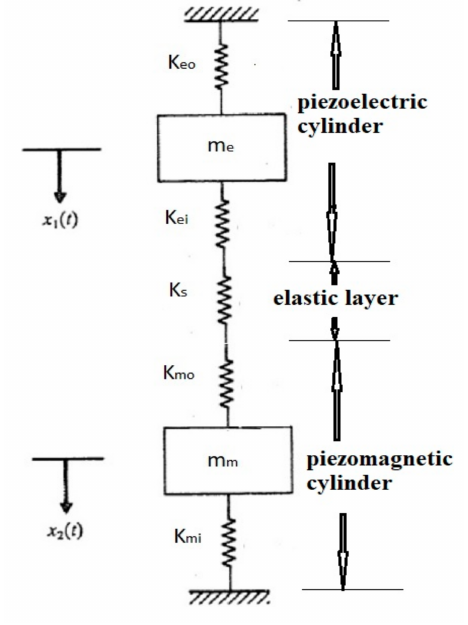
Figure A2. Dynamic model of the composite